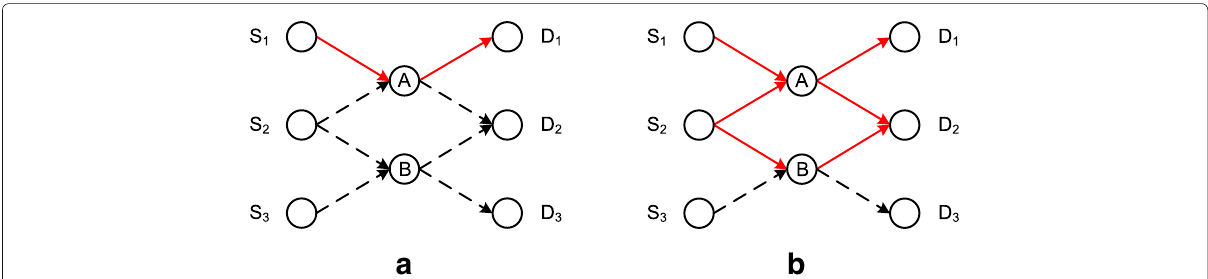
Fig. 1 a The partial knowledge of the channel gains available at source S 1 is denoted by solidarrows and b the partial knowledge of the channel gains available at relay